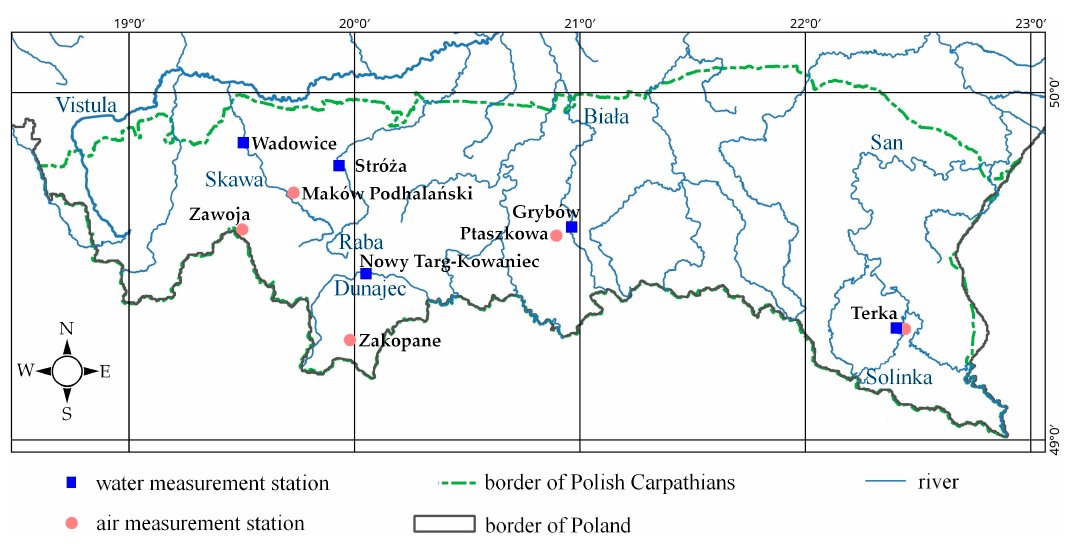
Figure 1. Study area with measurement stations used.